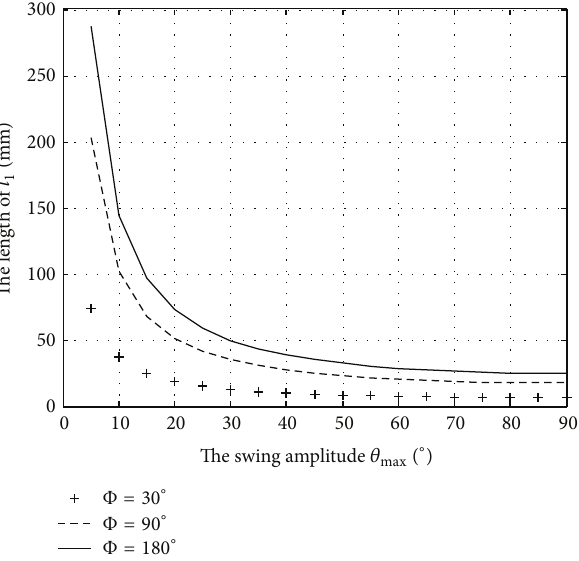
Figure 7: The rod length of the tail link varies with the swing